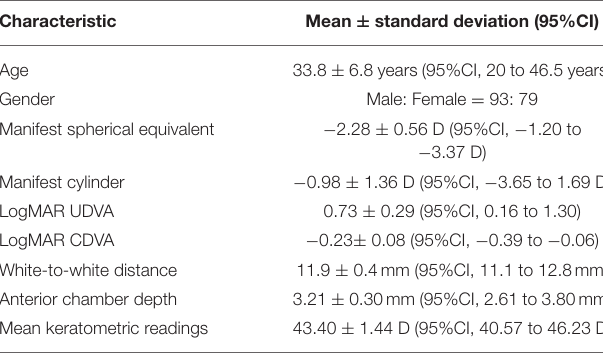
TABLE 1 | Preoperative demographics in eyes undergoing implantable Collamer lens (ICL) implantation for low myopia.